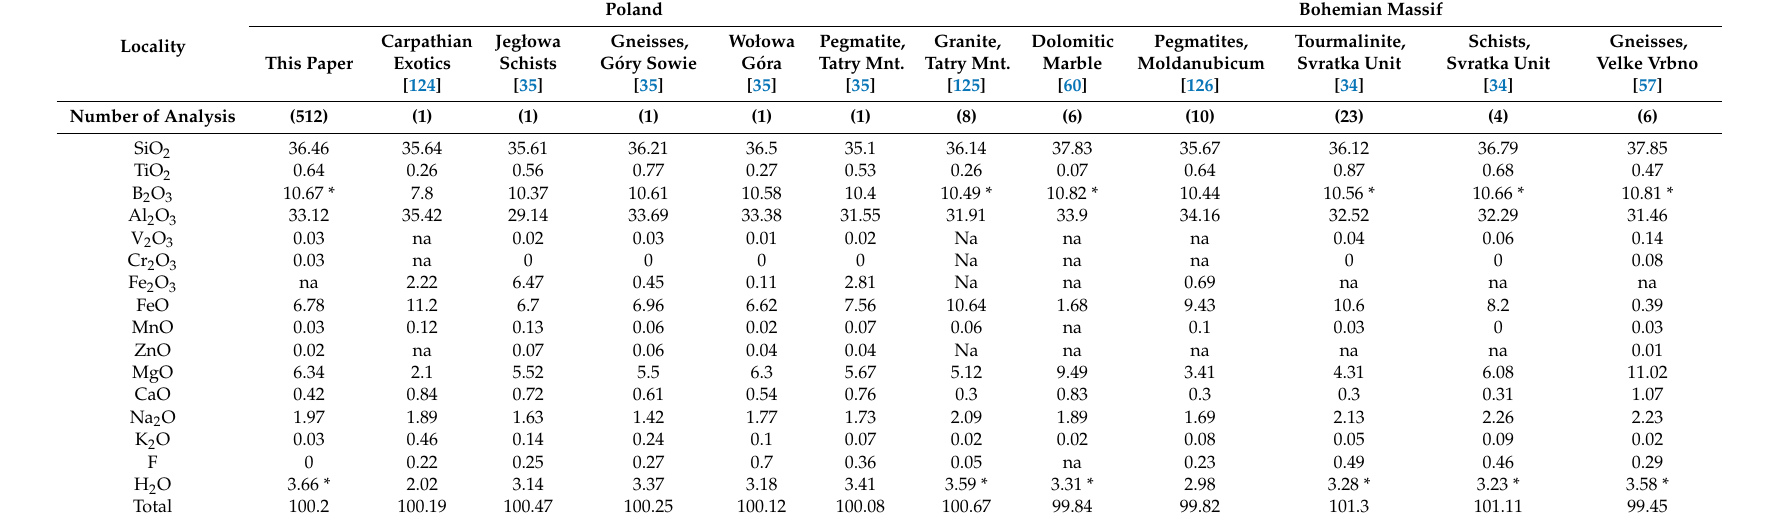
Table 3. Comparison of examined tourmaline grains from the Miech ó w Segment with tourmaline from neighbouring source areas.